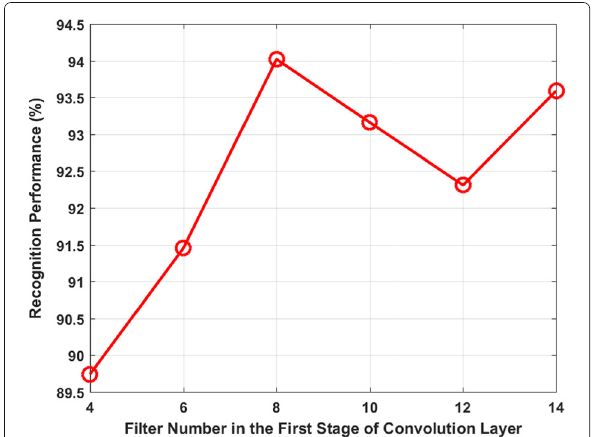
Fig. 4 Performance of the number of filters in the first stage on ICANet: There were eight filters in the second phase of convolution, and the number of filters in the first phase was gradually increased from 4 ∼ 14. The results show that ICANet obtained the best performance of facial recognition, as the filter number was 8